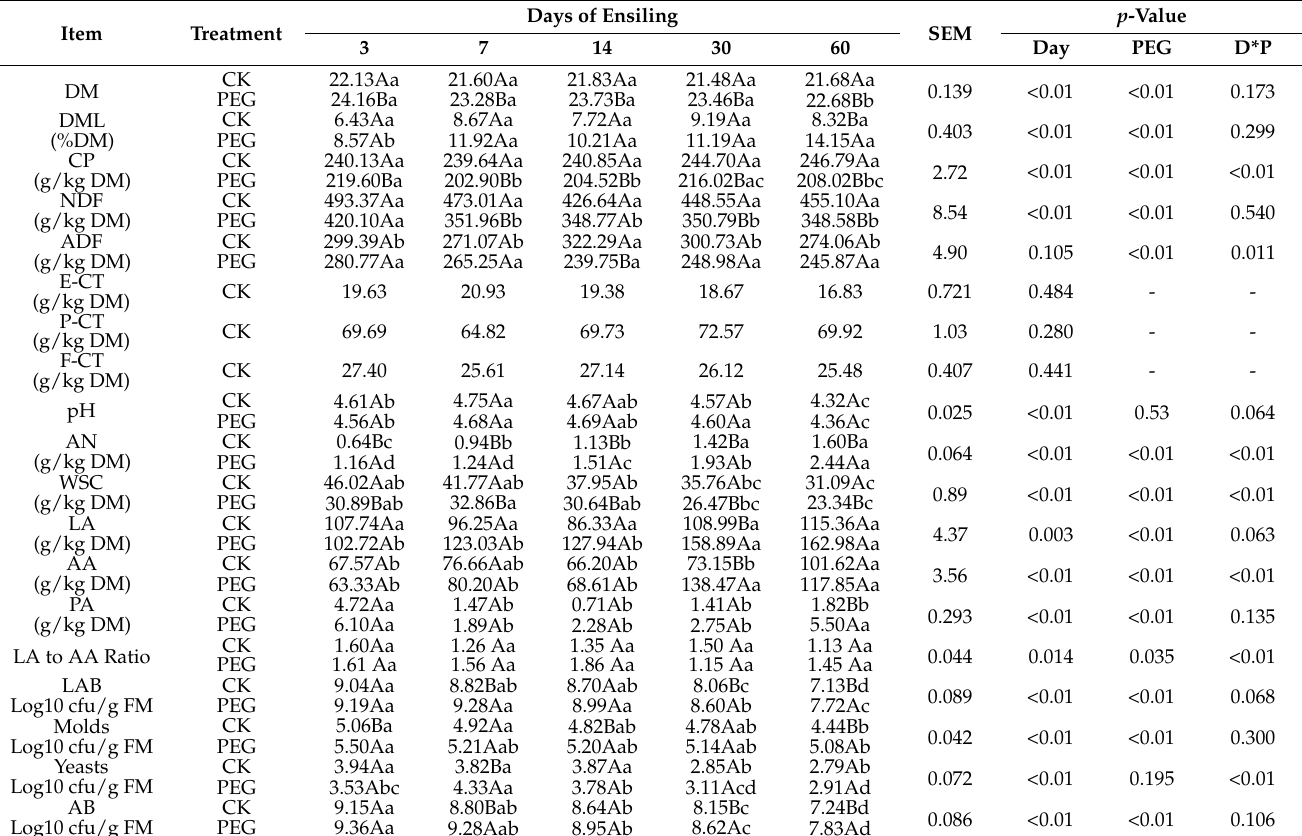
Table 2. Ensiling characteristics of sainfoin with or without the addition of PEG 1